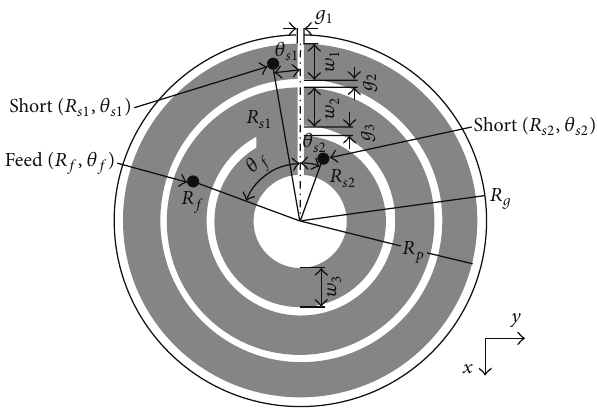
Figure 1: The geometry of the proposed implantable antenna.